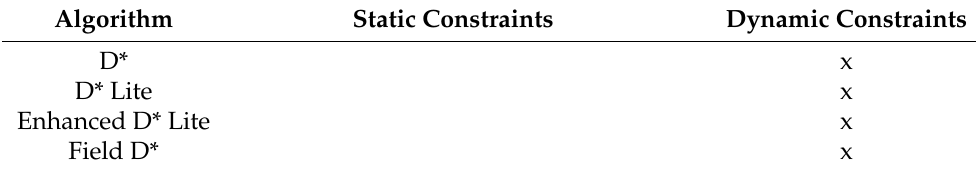
Table 4. Summary of D* and its